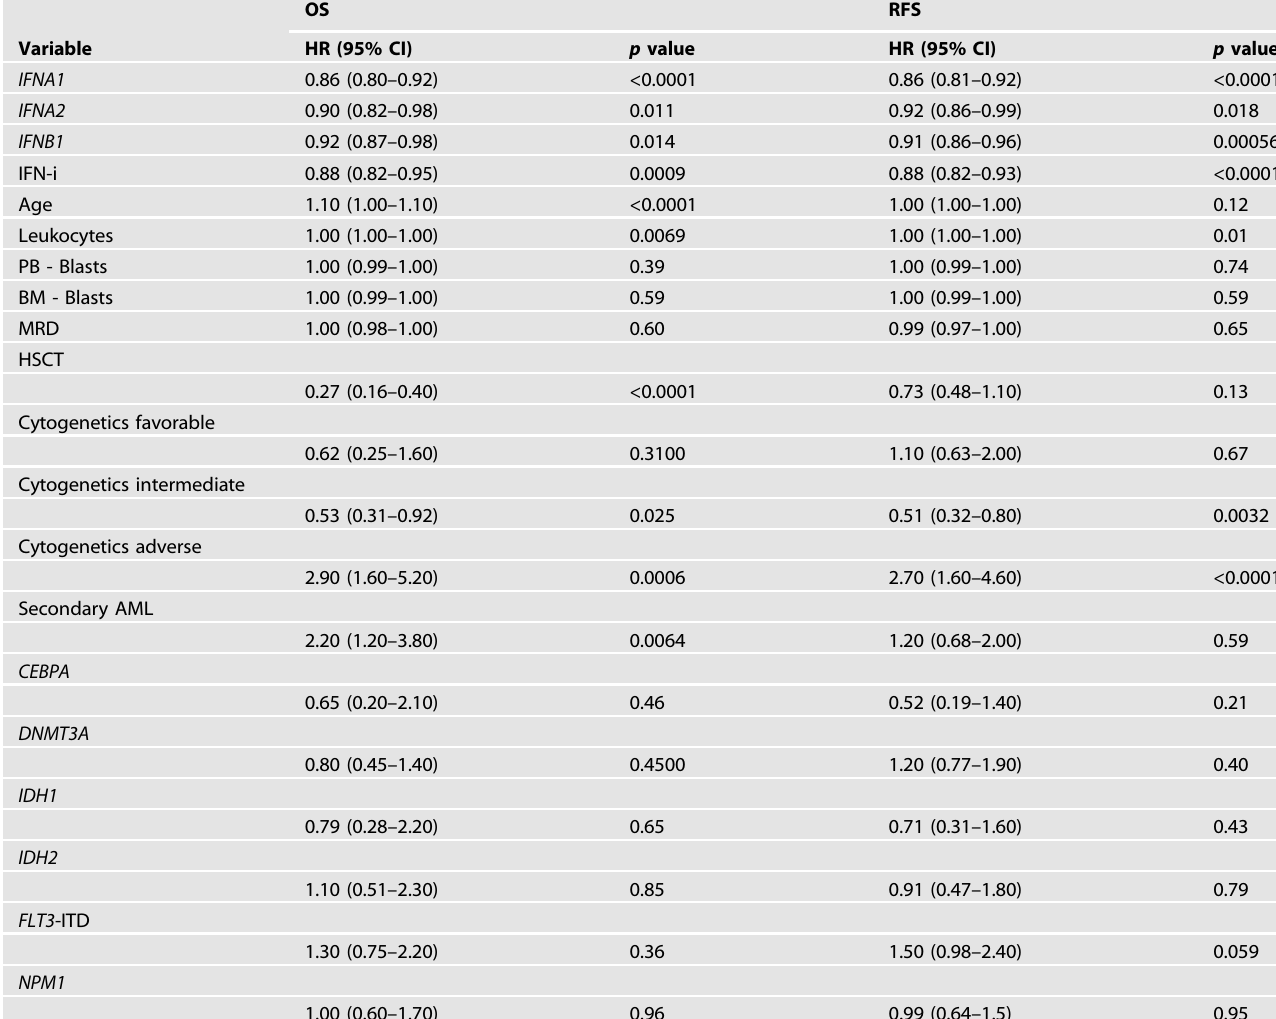
Table 2. Univariate Cox proportional hazard